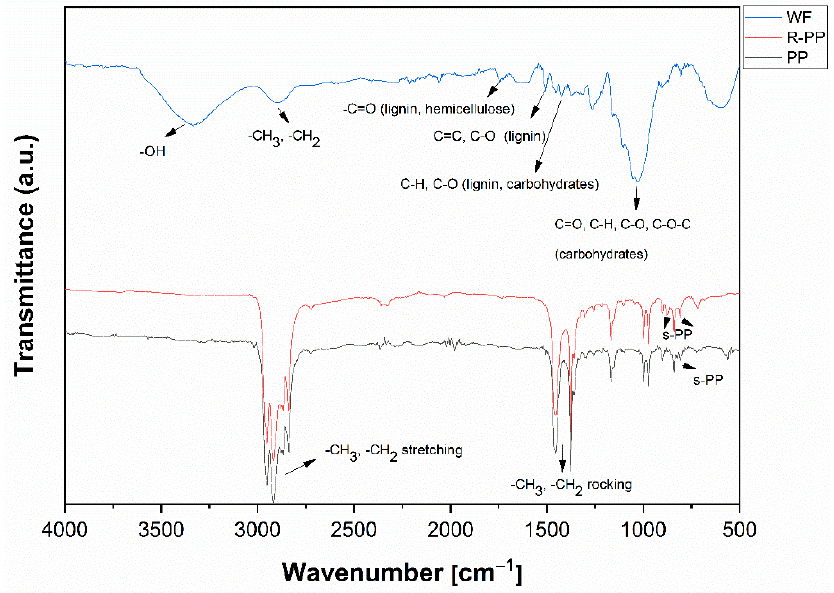
Figure 3. ATR-FTIR spectra of polypropylene (PP), recycled polypropylene (R-PP) and wood fiber Figure 3. ATR ‐ FTIR spectra of polypropylene (PP), recycled polypropylene (R ‐ PP) and wood fiber (WF).